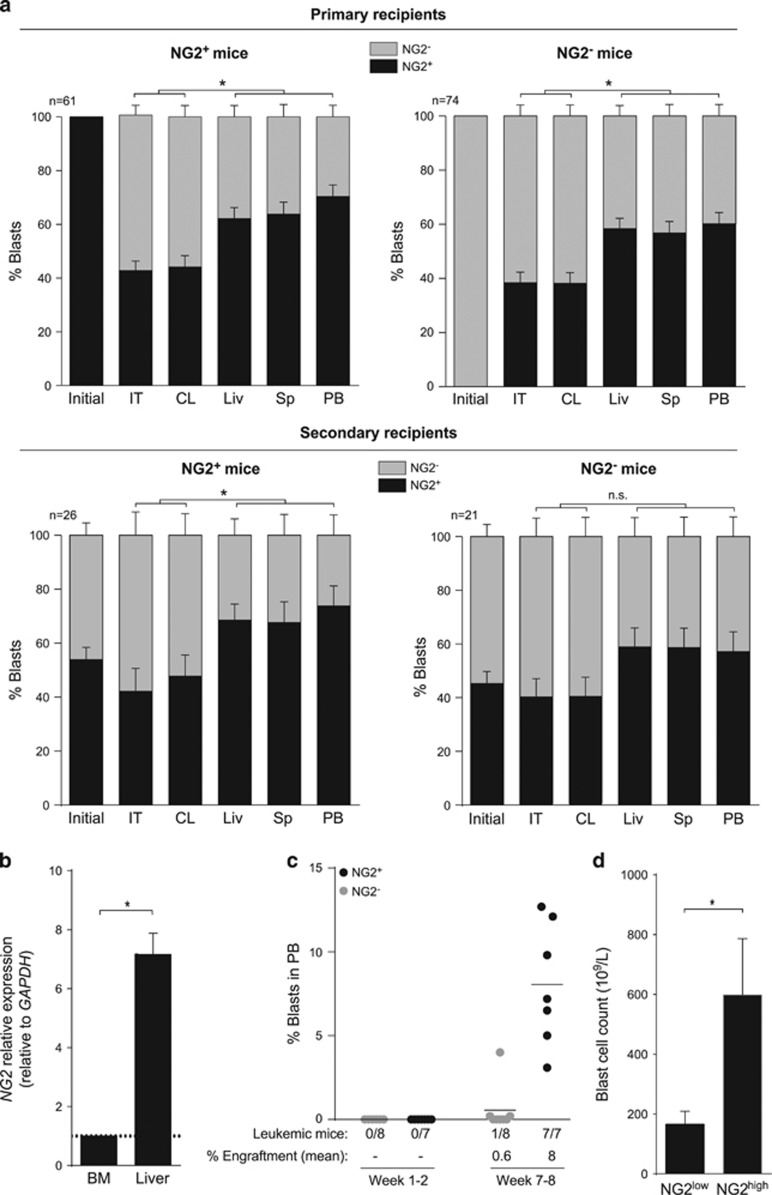
NG2 expression is upregulated in extramedullary hematopoietic tissues. (a) Percentage of NG2-expressing blasts (black bar) in primary (top panels) and secondary (bottom panels) engrafted mice at killing (n=245). The following tissues were analyzed: IT, intra-tibia; CL, contralateral tibia; Liv, liver; Sp, spleen; PB, peripheral blood. Left panels, NG2+ mice. Right panels, NG2− mice. The initial condition represents the percentage of NG2-expressing cells at the moment of transplantation: 100% for primary NG2+ mice (black bar) and 0% for primary NG2− mice (gray bar). (b) RT-qPCR confirming sevenfold higher expression of NG2 in xenografted liver as compared with BM. (c) NG2+ and NG2− cells were sorted and IV injected. Mice were weekly monitored by FACS for chimerism and killed after 7–8 weeks. Leukemia engraftment in PB is shown for NG2+ (black dots) and NG2− (gray dots) transplanted mice. (d) Threefold higher WBC counts in diagnostic NG2high versus NG2low MLL-AF4+ infants. Mean of NG2+ cells was used as cutoff (Table 1). *P<0.05; NS, not significant.